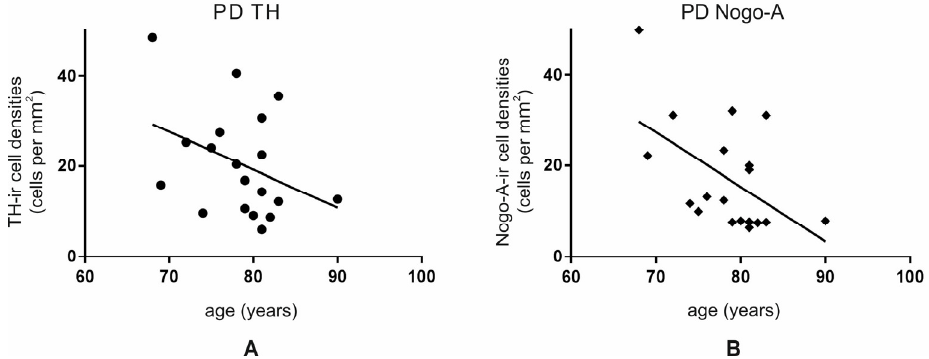
Figure 6. Analysis of TH-ir ( A ) and Nogo-A-ir cell densities ( B ) per mm 2 depending on the age in the human SNc from PD individuals. Both markers displayed a significant decline with age.